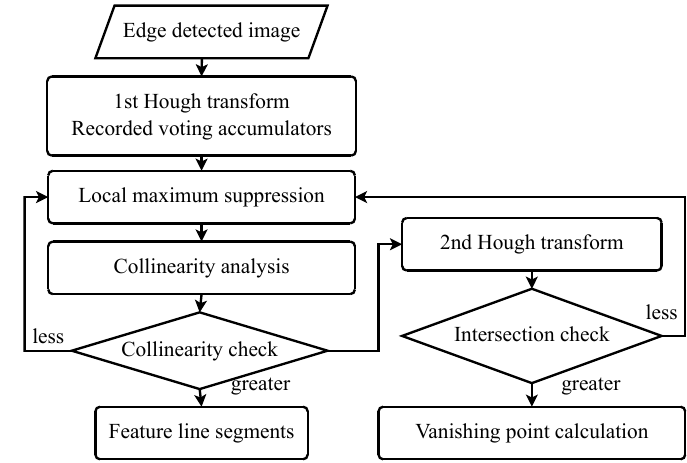
Figure 1. The procedure of initial vanishing point detection using double Hough